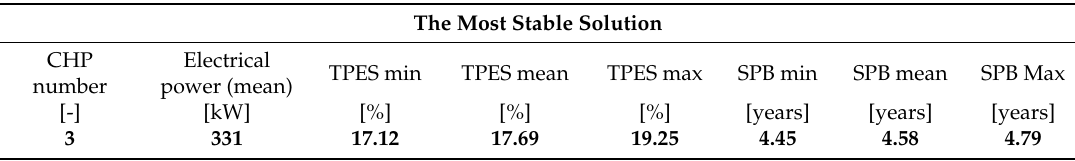
Table 5. Main characteristics of the most stable energetic and economic solution.